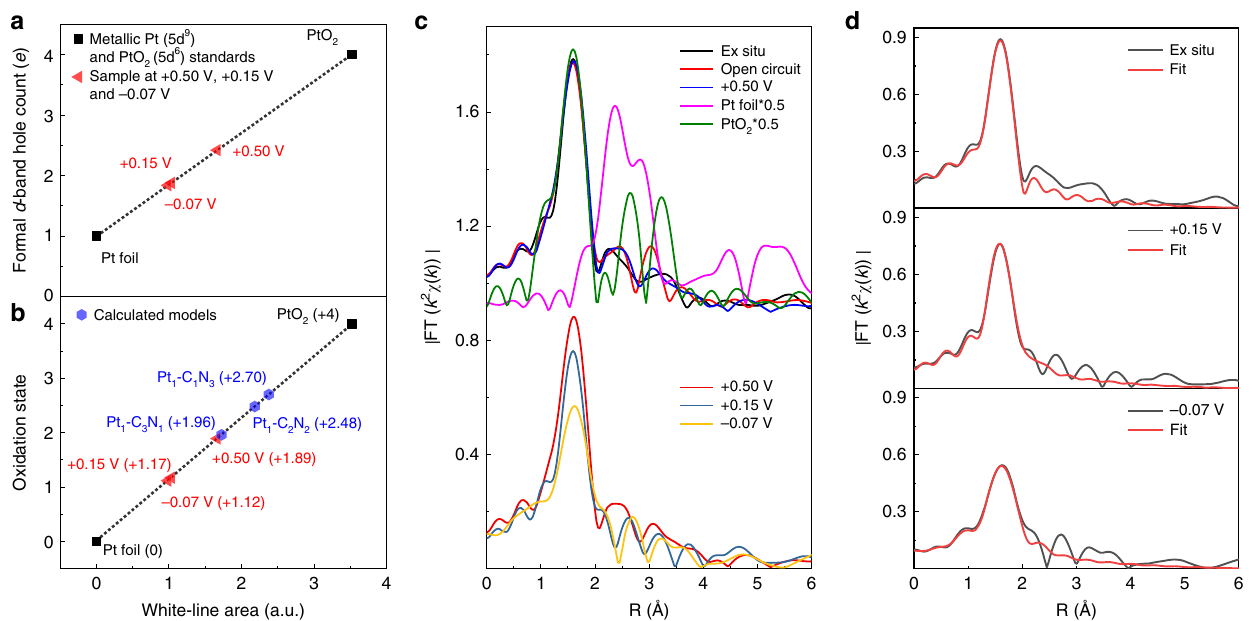
Fig. 2 Operando EXAFS and Δ XANES characterization. a The fi tted average formal d -band hole counts and b oxidation states of Pt from Δ XANES spectra, depicted with the calculated oxidation states of Pt 1 -C 3 N 1 , Pt 1 -C 2 N 2 , and Pt 1 -C 1 N 3 models. The oxidation state of Pt 1 -C 3 N 1 are the most proximate to that of the ex situ sample. c Corresponding k 2 -weighted Fourier transform (FT) spectra of Fig. 1e. d First-shell fi tting of EXAFS spectra under ex situ, + 0.15 V and − 0.07 V